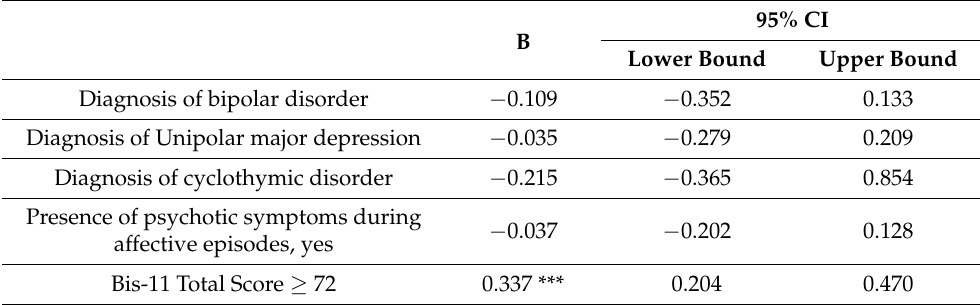
Table 3. Linear regression analyses. Dependent variable: Number of lifetime suicide attempts.